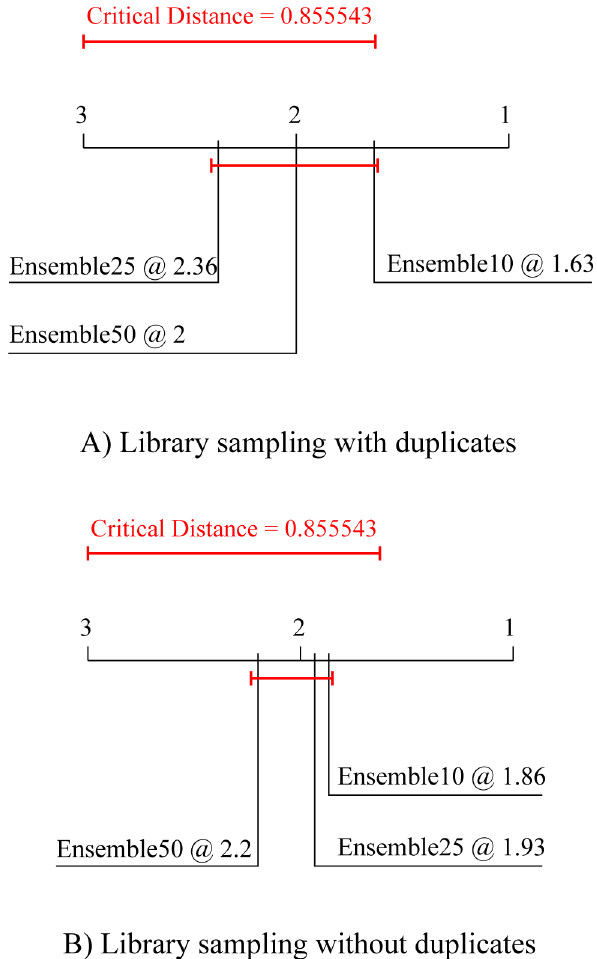
Fig 4. Comparison of the average ranks for predictive performance of the two library sampling methods with different ensemble sizes. Average ranks of ensembles that include 10, 25, and 50 base models in terms of predictive performance averaged over the 15 experimental data sets for Library sampling (A) with and (B) without